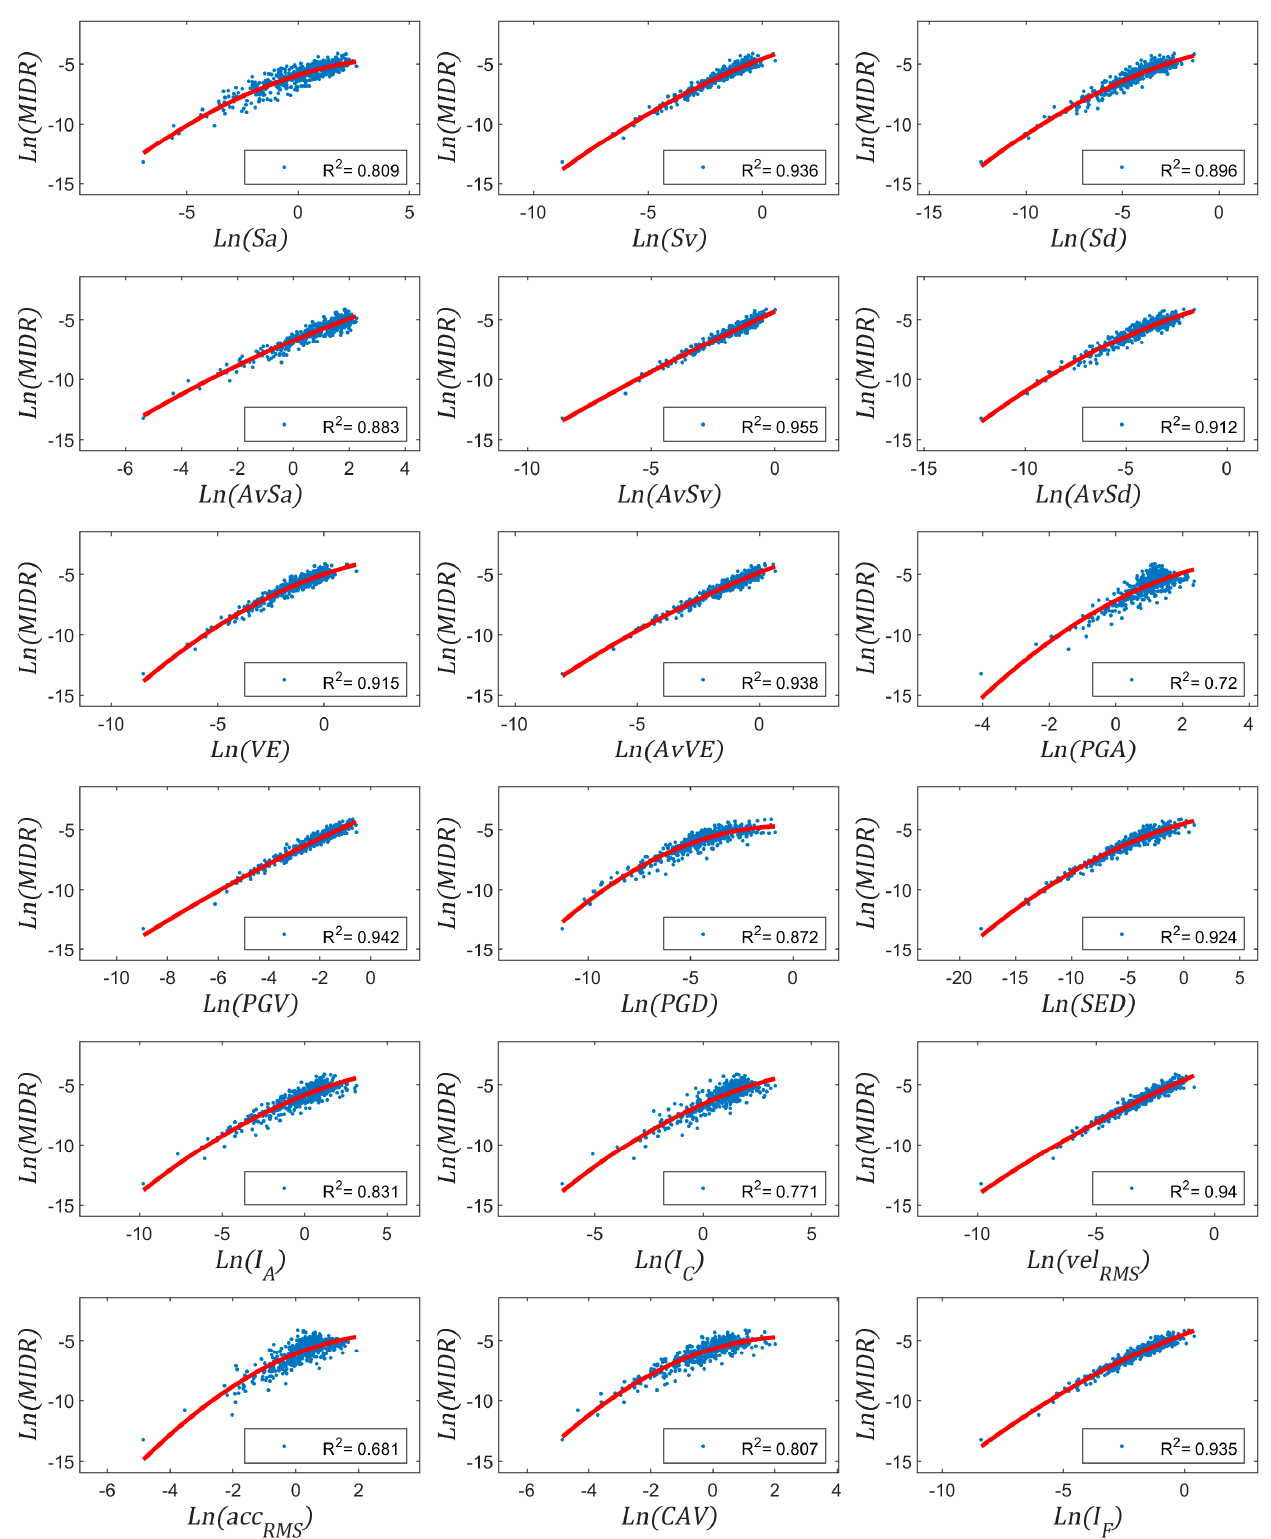
Figure 10. Correlation coefficient between IMs and MIDR in the log-log space for far-fault records.